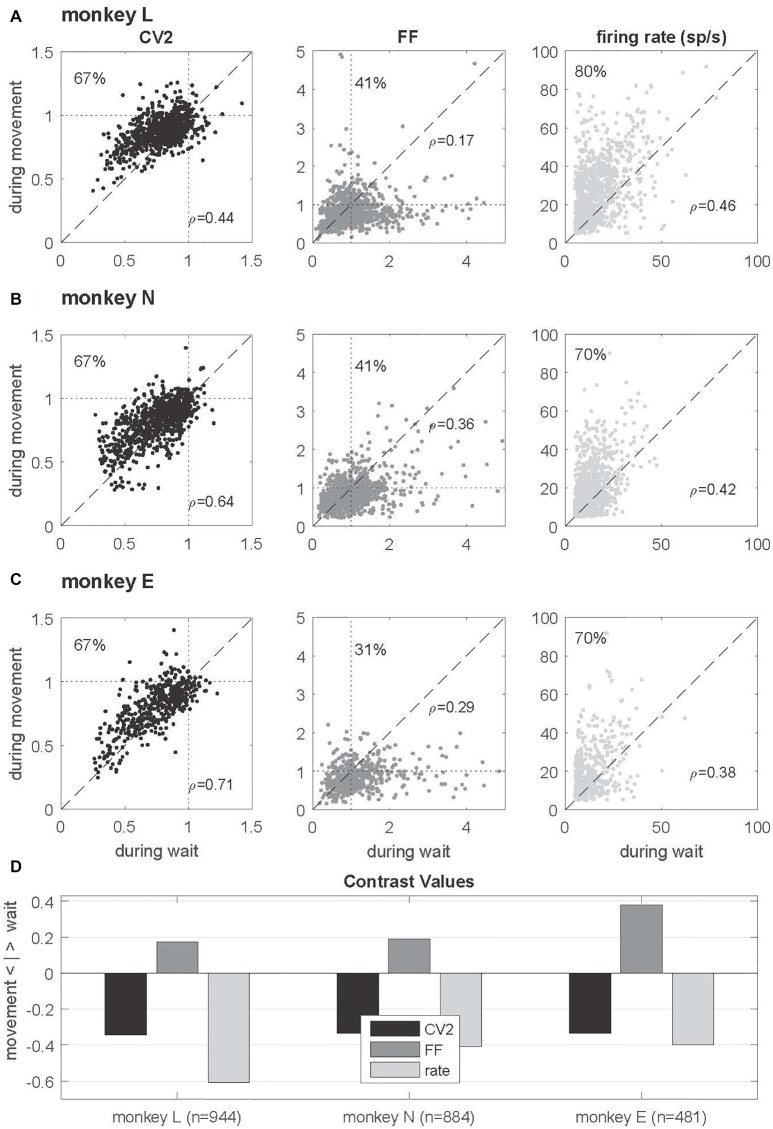
Single neuron comparison of variability measures and firing rate. (A–C) Scatterplots of CV2 (in black), FF (in dark gray) and firing rate (in light gray) obtained during wait (x-axis) and movement (y-axis) for monkey L (n = 944), N (n = 884) and E (n = 481) for neurons fulfilling the selection criteria in both epochs. The number in the upper left corner indicates the percentage of neurons whose values are higher during movement than during wait. In the right lower corner of each plot the rank correlation coefficient rho (Spearman) is indicated. All correlations are positive and highly significant (p < 0.001). (D) Contrast values for each feature. Data in this figure were obtained during the trial type SG-HF, for results in the other trial types see Supplementary Figure S2.